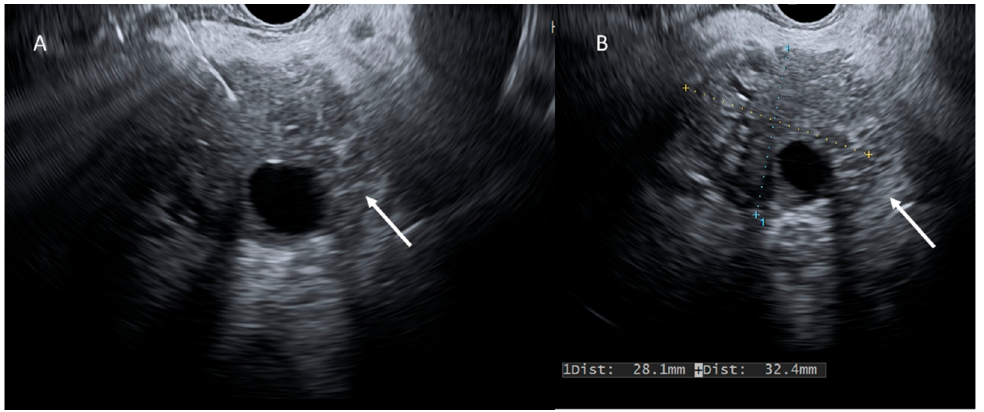
Figure 4. EUS evaluation ( A , B ); PDAC (arrows) appears as a heterogeneous hypoechoic